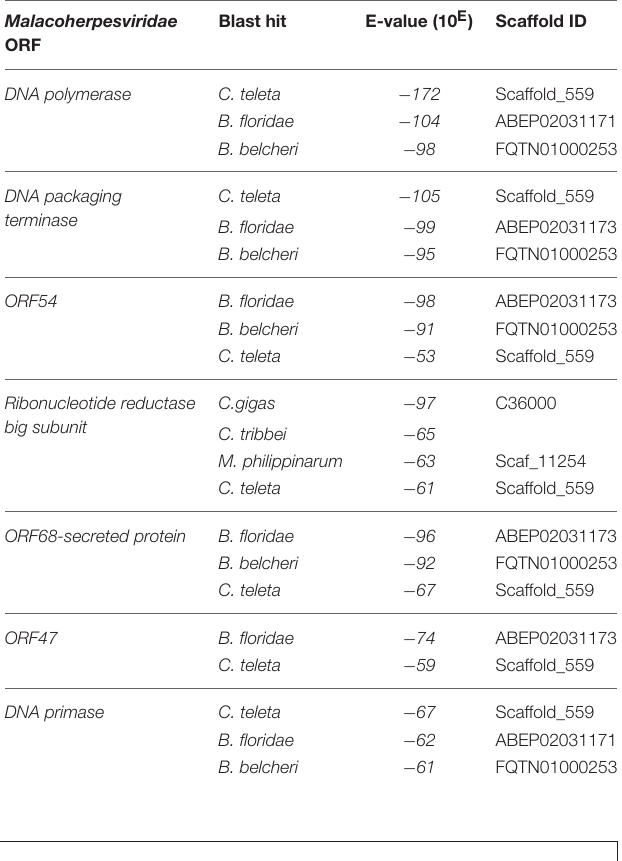
Malacoherpesviridae ORF